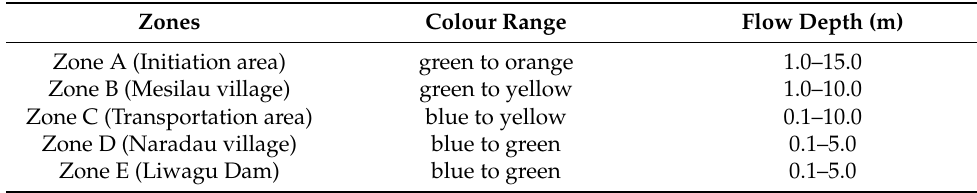
Table 5. The flow depth of every zone.